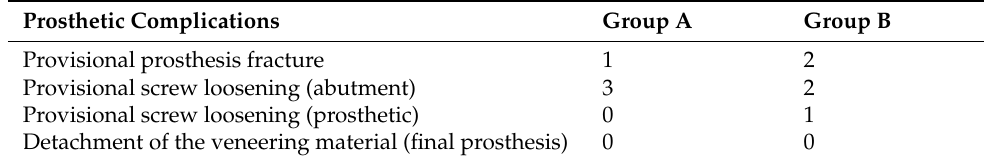
Table 5. Prosthetic complications classified by